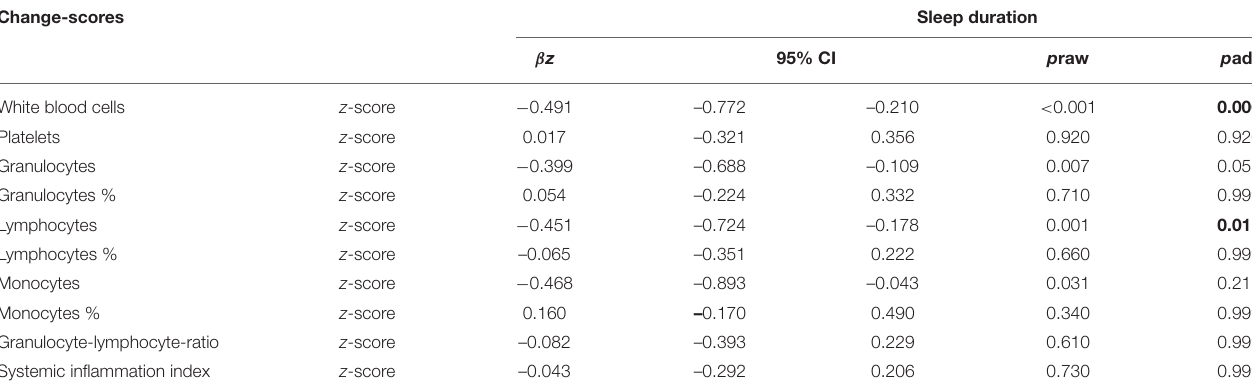
TABLE 2 | Results of the univariate regression analysis using generalized estimating equations for capillary immunological blood markers and sleep duration. Change-scores